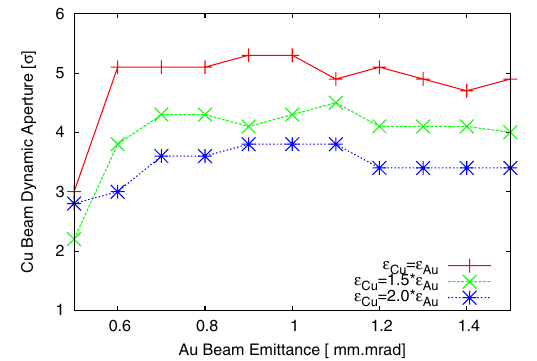
FIG. 15. Calculated dynamic aperture for the Cu beam with matched and unmatched beam sizes as the Au beam. The horizontal axis is the Au beam ’ s transverse normalized rms emittance. The Au bunch intensity is 1 . 3 × 10 9